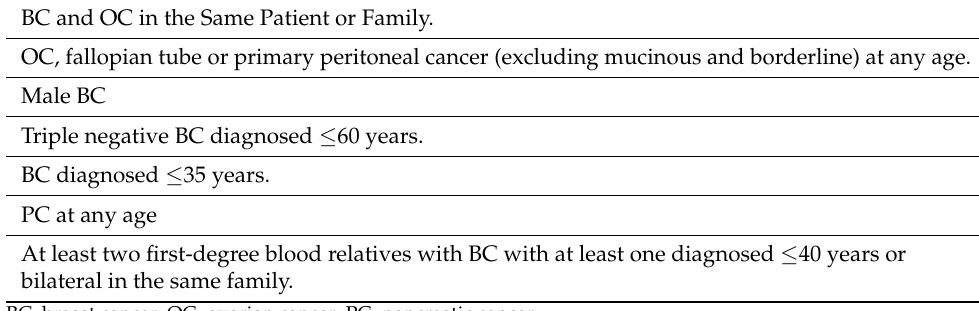
Table 1. The MFCC criteria for genetic testing in BC, OC and PC cancer